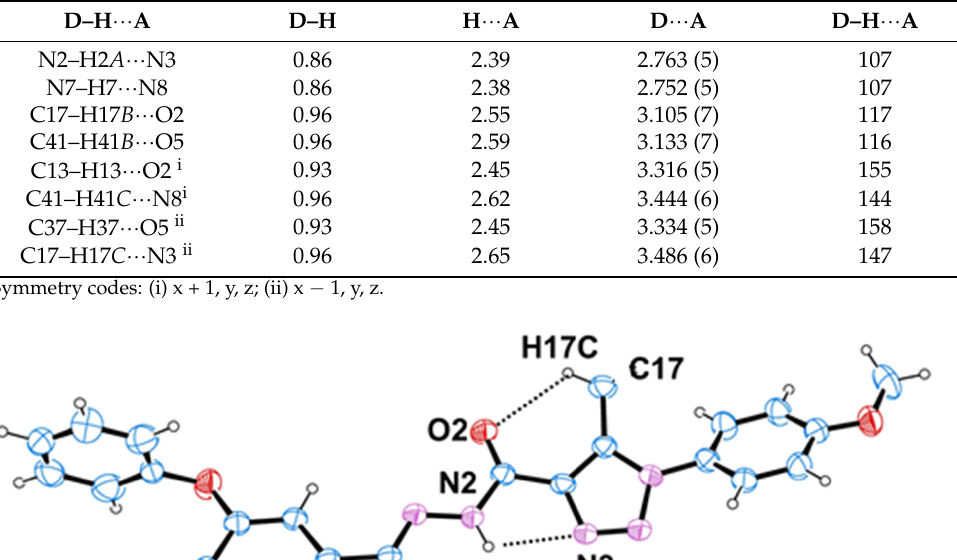
Table 1. Hydrogen bond geometry (Å, ° ) of compound 2 .